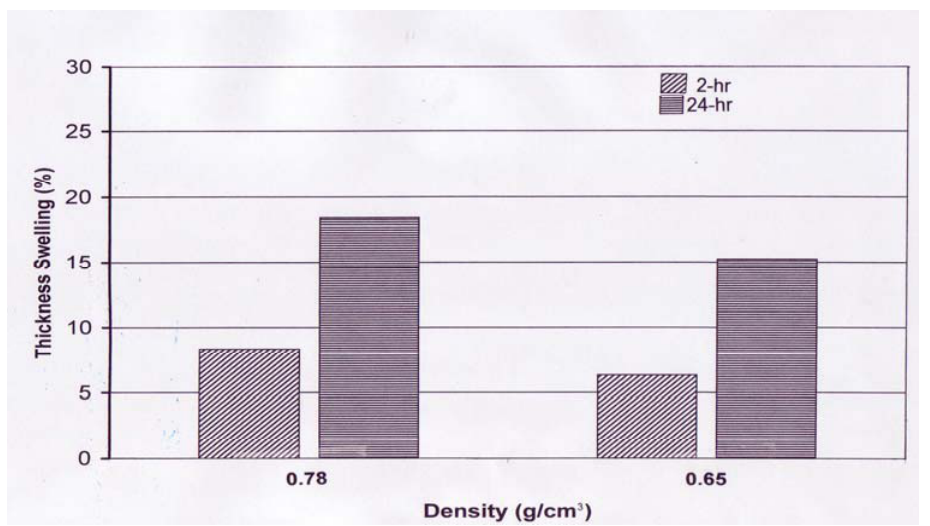
Figure 4. Internal bond (IB) strength values of the